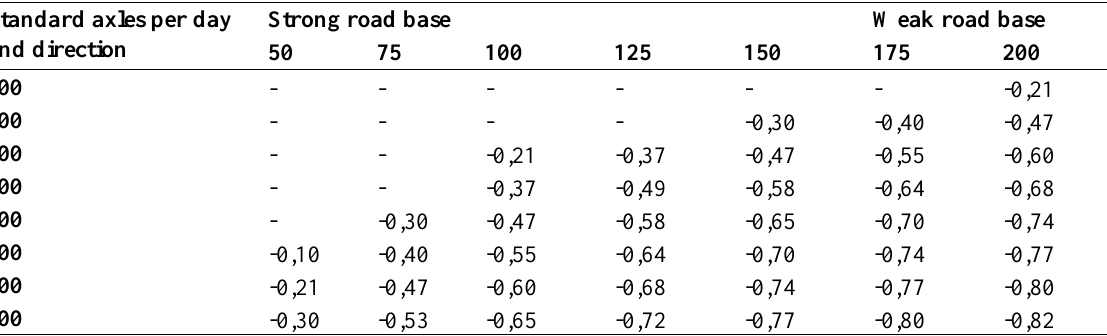
Strong road base Weak road base Standard axles per day